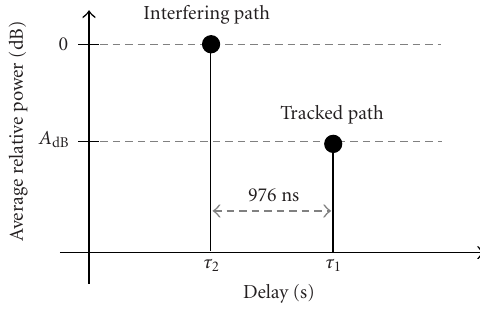
Figure 7: Delay-power profile of channel.